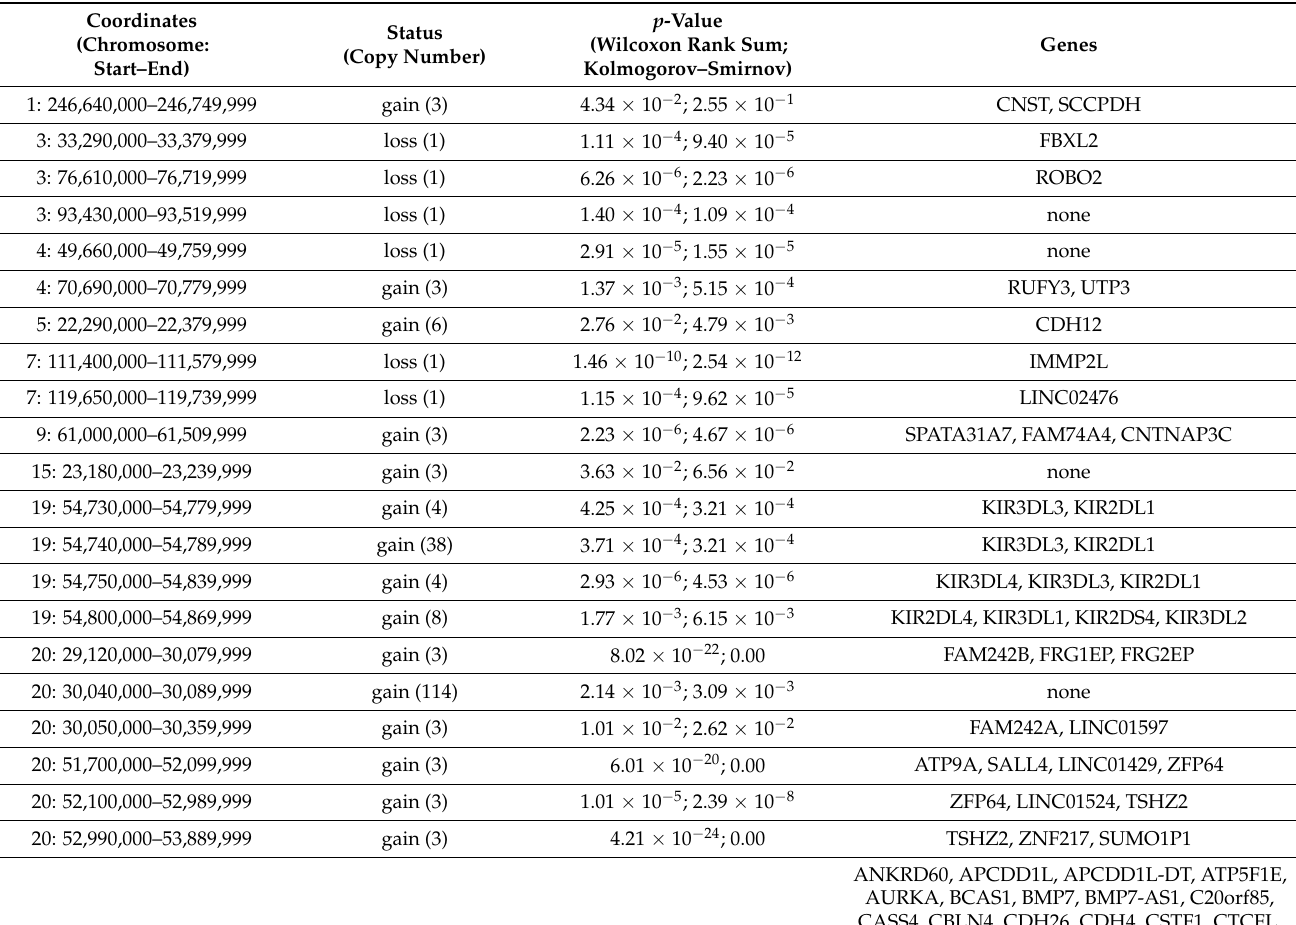
Table 2. WGS-CNV analysis. List of the genes present in copy number variation in the genome of HEK293T cell line treated with PDAC patients’